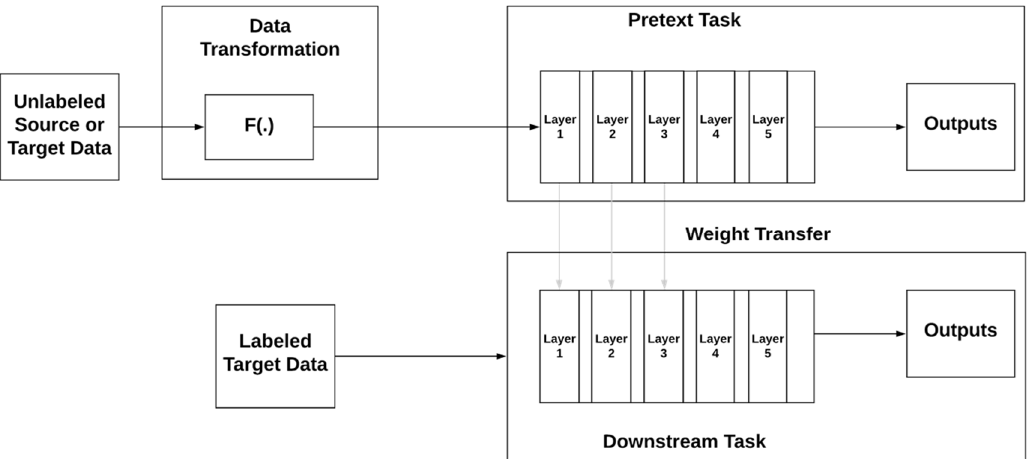
Figure 5. A standard SSL framework. Unlabeled source or target data are transformed to create an auxiliary supervisory signal. The CNN is pretrained to accomplish a pretext task using either target data or separate source data, and then the weights from layers 1–3 are reused when training to accomplish a downstream task using the target data.